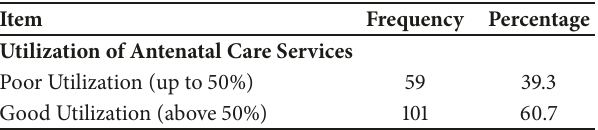
Table 4: Overall utilization of antenatal care